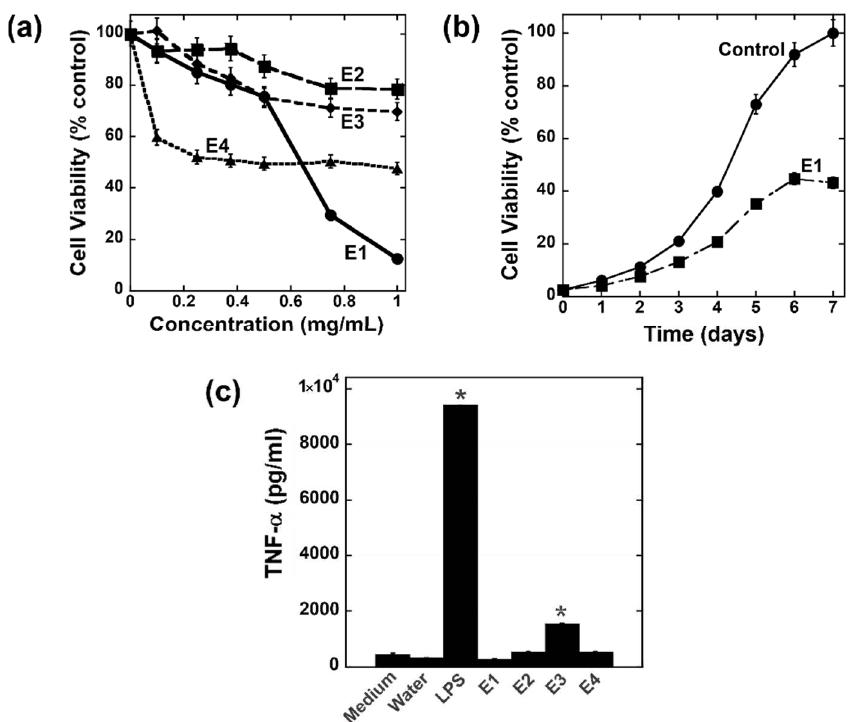
Figure 1. Antiproliferative and immunomodulatory activities of crude extracts from O. tomentosa . Dose- ( a ) and time-dependent ( b ) MTT cell viability assays on HeLa cells. The concentration of E1 used for the time-dependent experiment ( b ) was 0.5 mg/mL. ( c ) At 1 mg/mL, crude extracts from O. tomentosa were assessed for their ability to induce TNF- α production in RAW264.7 macrophage cells as an indicator of immunomodulation. Lipopolysaccharide (LPS) was used as a positive control, whereas medium and water were used as negative controls. The results presented are representations of two separate experiments (n = 2). Error bars are SD. One-way ANOVA (Tukey Test) was used for statistical analysis. * denotes p < 0.05 as compared to the water control.